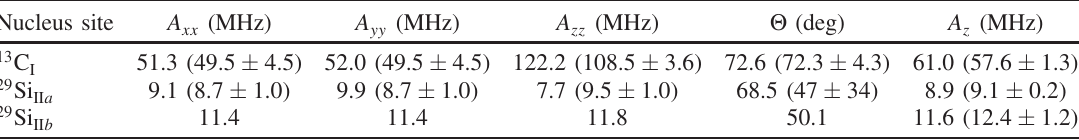
TABLE I. Density functional theory simulations of the neutral 3C-SiC divacancy ’ s hyperfine tensors for 13 C and 29 Si nuclei, and our reconstructions from experimental data obtained from Ky5/L3 defects. The experimental values in parentheses are inferred from a global fit to pulsed ODMR measurements taken on single Ky5/L3 defects that are strongly coupled to a nearby nuclear spin, and are reported in parentheses with 95% credible intervals. The large uncertainty on θ for 29 Si is a consequence of the fact that the tensor is nearly isotropic within the MHz resolution II a of our